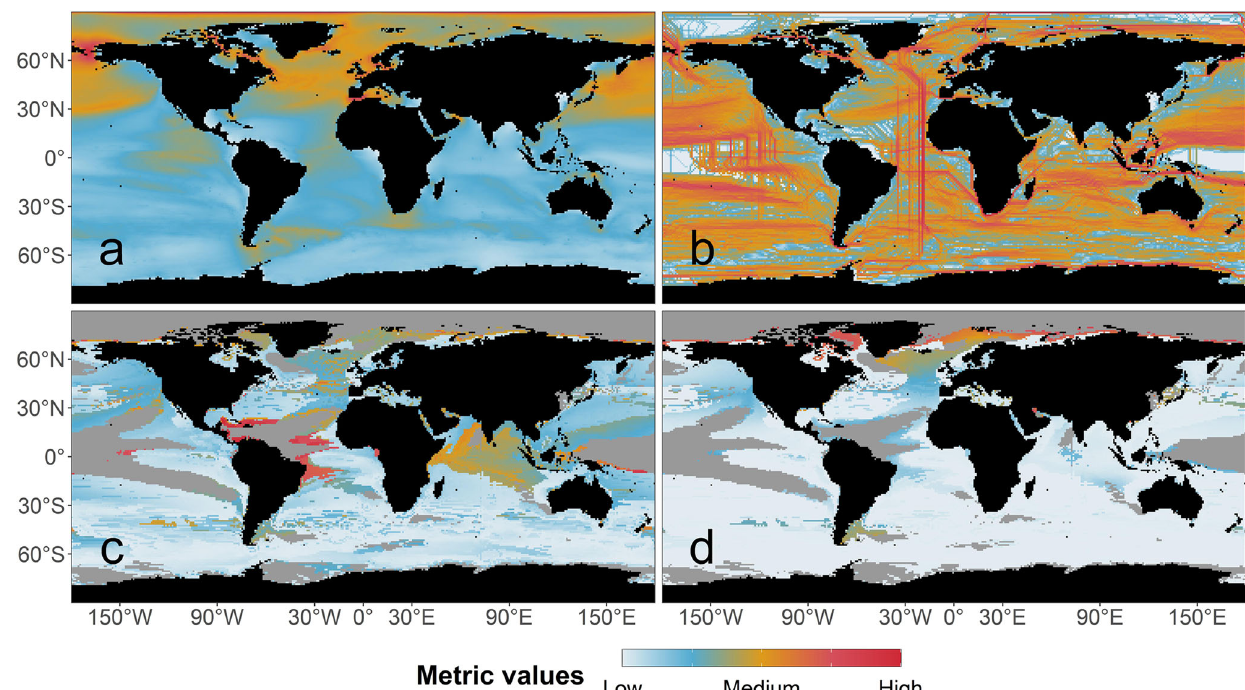
Fig. 2 Global map of the marine environment showing pixel prioritization based on four connectivity metrics. The metrics displayed are current fl ow a , path density b , minimum exposure distance, c and minimum cumulative exposure d . Pixels were evaluated based on how they facilitated movement between thermal analogs a , b , the length of the trajectory used to reach their thermal analogs c , and exposure to dissimilar climates through that trajectory d . Metric values ranged from low (white) to high (red). Values for a and b were log-transformed to aid interpretation. Pixels with no thermal analogs in c and d are shown in grey. Pixels with no climatic data, land masses, and water masses that are blocked by land masses are shown in